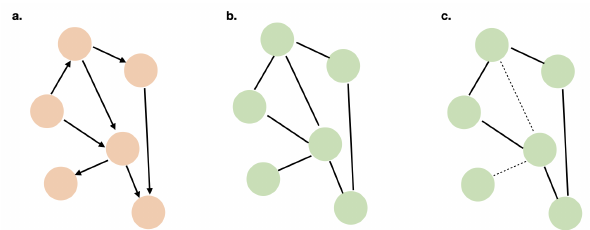
Figure 1. Imaginary representation of ( a ). Directed whole graph ( b ). Undirected whole graph ( c ). Undirected training